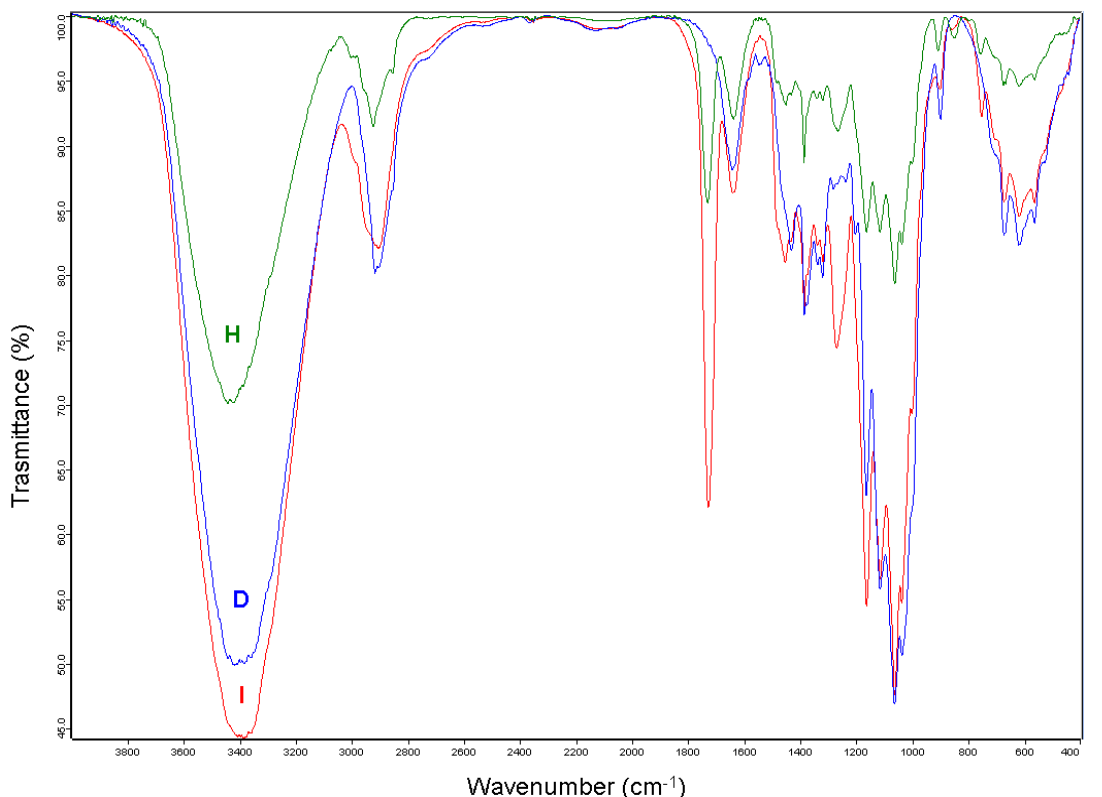
Figure 6. FT-IR spectra of cellulose D and cellulose derivatives H and I in a KBr